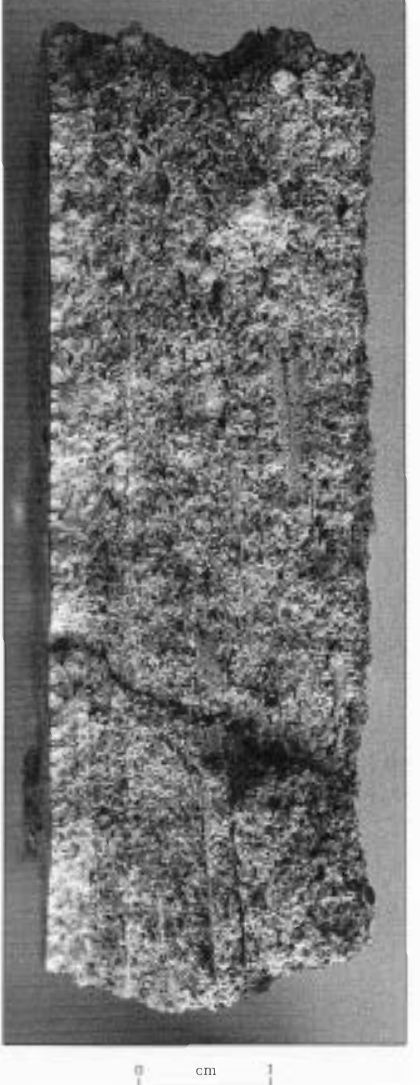
Figure 4 Section through the surface lay­ ers of plaster of very good quality from Penaflor, southern Spain, showing the use of a fine white filler for the layer [left) near­ est the painted swface (extreme left). cultures. Yellow ochre (limonite) is a yel­ low form of hydrated iron oxide and is also fairly widely found.6 Green earth occurs as two clay minerals (celadonite and glauco­ nite}, each of which has a significant iron content. The colour is seldom very strong and varies from blueish green to yellowish green, depending on the iron content. 7 Carbon black was obtained by charring animal bone or plant matter Sl,lch as vine twigs. White normally came from some form of calcium or magnesium